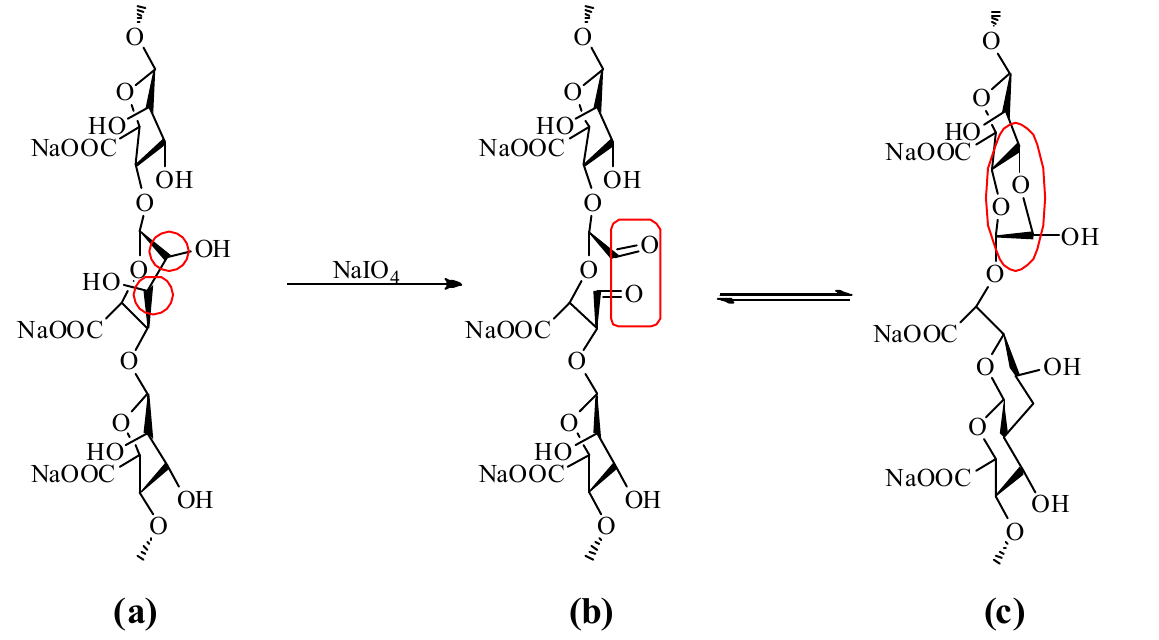
Figure 2. Schematic presentation of ( a ) the oxidation reaction of sodium alginate by NaIO 4 , ( b ) the formation of OSA, and ( c ) the formation of hemiacetal.